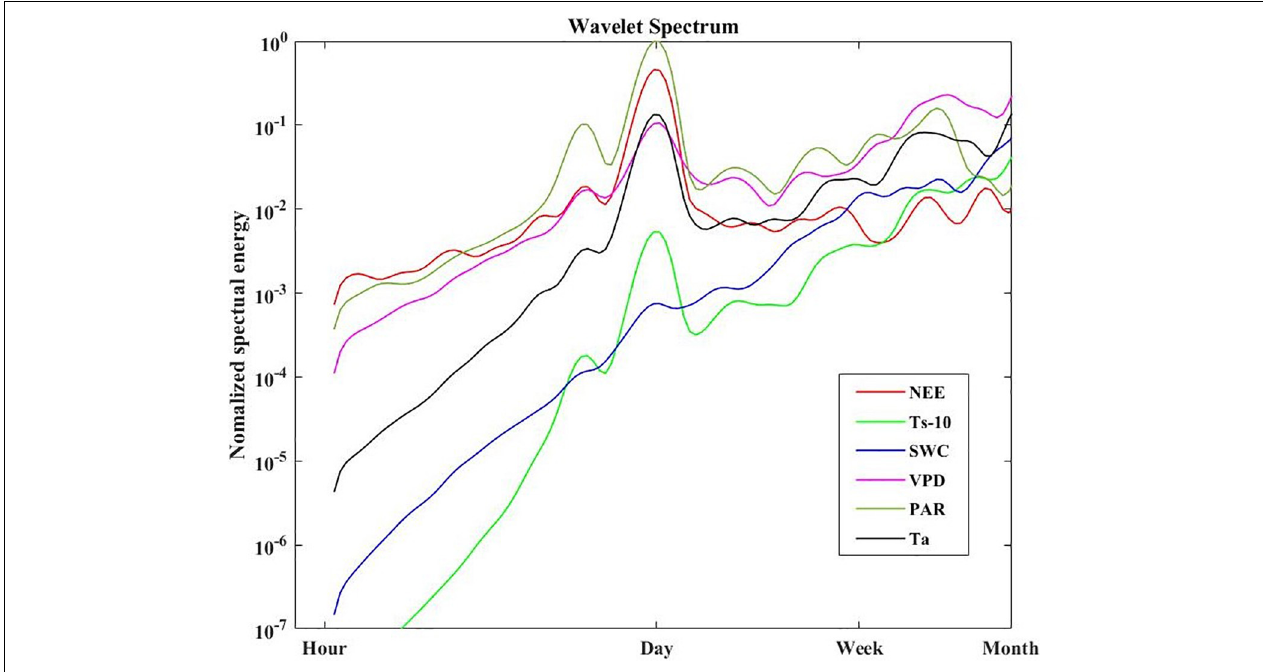
FIGURE 6 | Normalized global wavelet energy spectra for NEE, Ts-10, SWC, VPD, PAR, Ta.